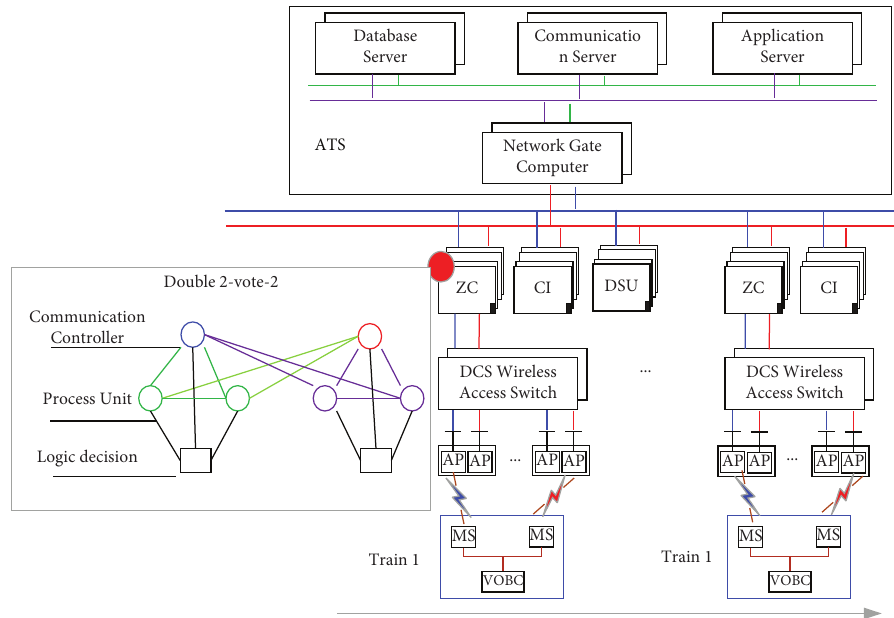
Figure 2: A typical CBTC